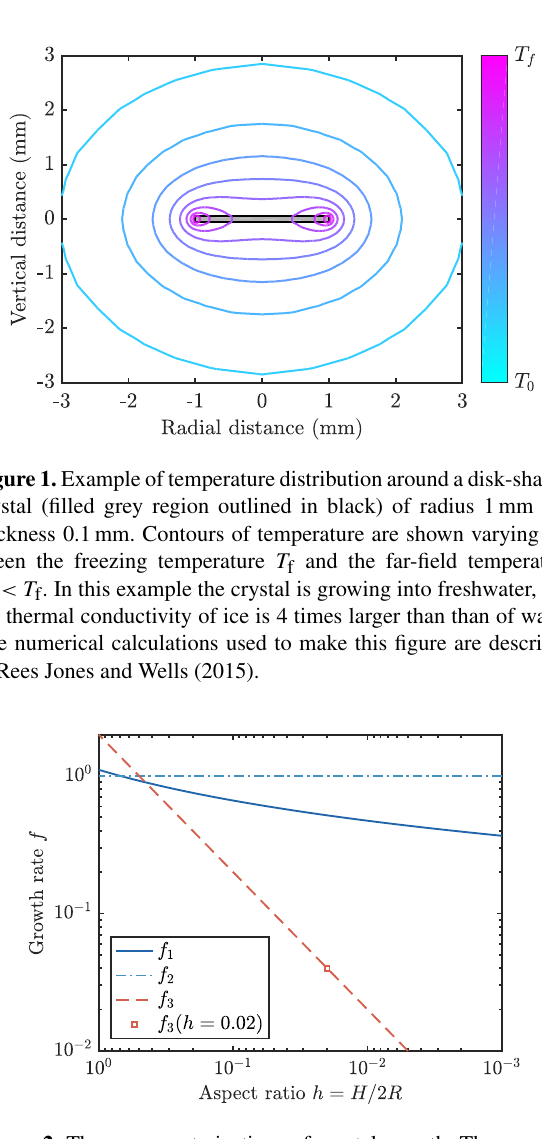
Figure 2. Three parameterizations of crystal growth. The parame- terization f 1 (solid dark blue curve) is the result of a detailed numer- ical calculation (Rees Jones and Wells, 2015). Parameterizations f 2 (dot–dash light blue curve) and f 3 (dashed red line) are obtained by scaling analysis, as described in the text. The growth rates f 1 and f 2 are comparable, but f 3 is much smaller at typical small aspect ratios. We also indicate (square marker) the growth rate if a constant aspect ratio h = 0 . 02 is